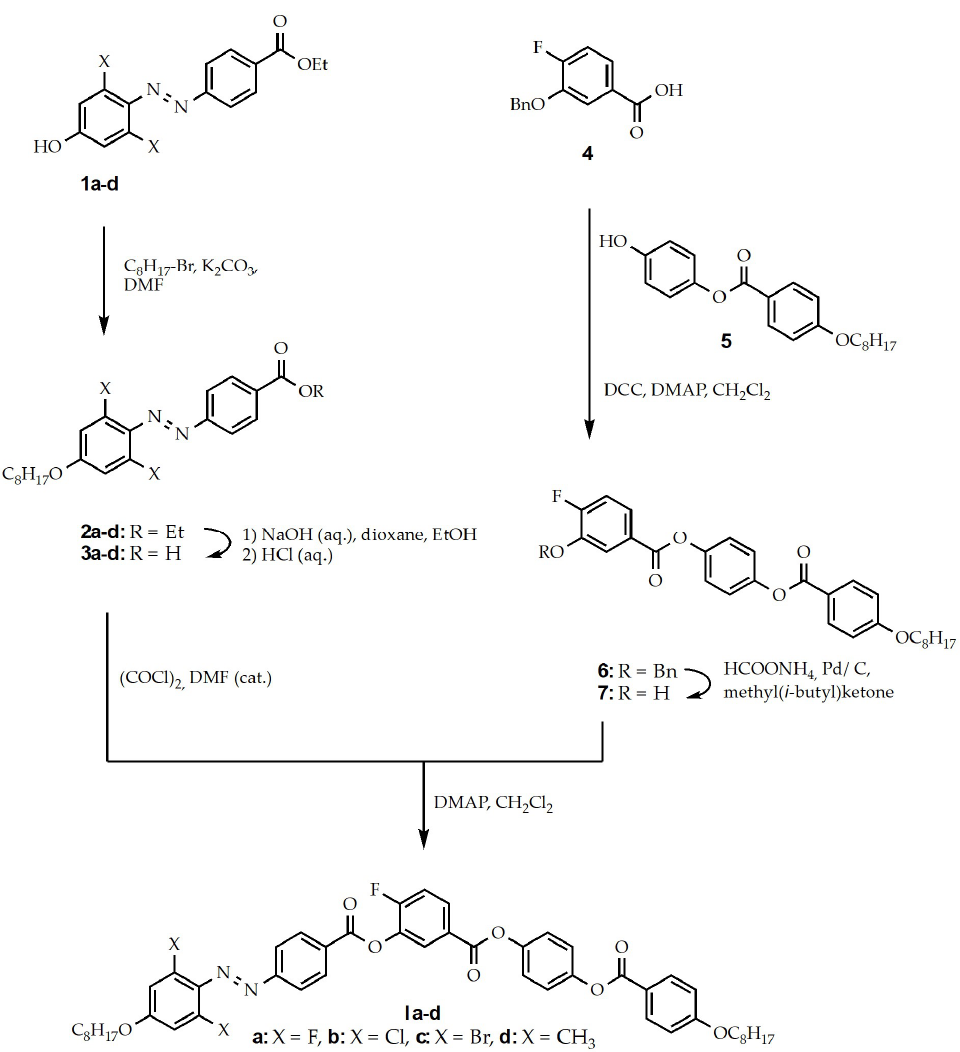
Figure 2. Synthesis of the final materials Ia-d.